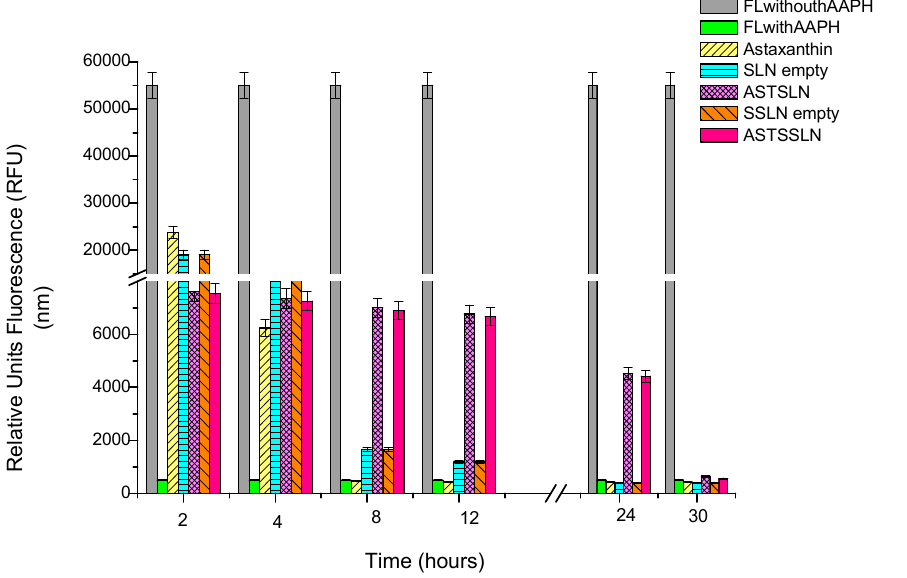
Figure 9. ORAC assay of free AST, empty SLN and SSLN, AST-SLN, and AST-SSLN. FL = fluores- cein; FL + AAPH = fluorescein solution containing AAPH (2,2’-azobis(2-methylpropionamidine) dihydrochloride). Data represent the mean of three independent experiments ± SD.